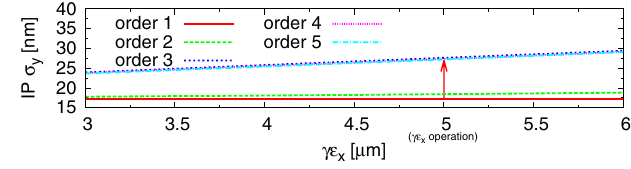
FIG. 4 (color online). σ (cid:1) y evaluated by MAPCLASS as a function of γϵ x for the ATF2 ultralow β (cid:1) considering the expected multipole components of the PM magnet for QD0FF. The value of γϵ x when operating ATF is 5 μ m.